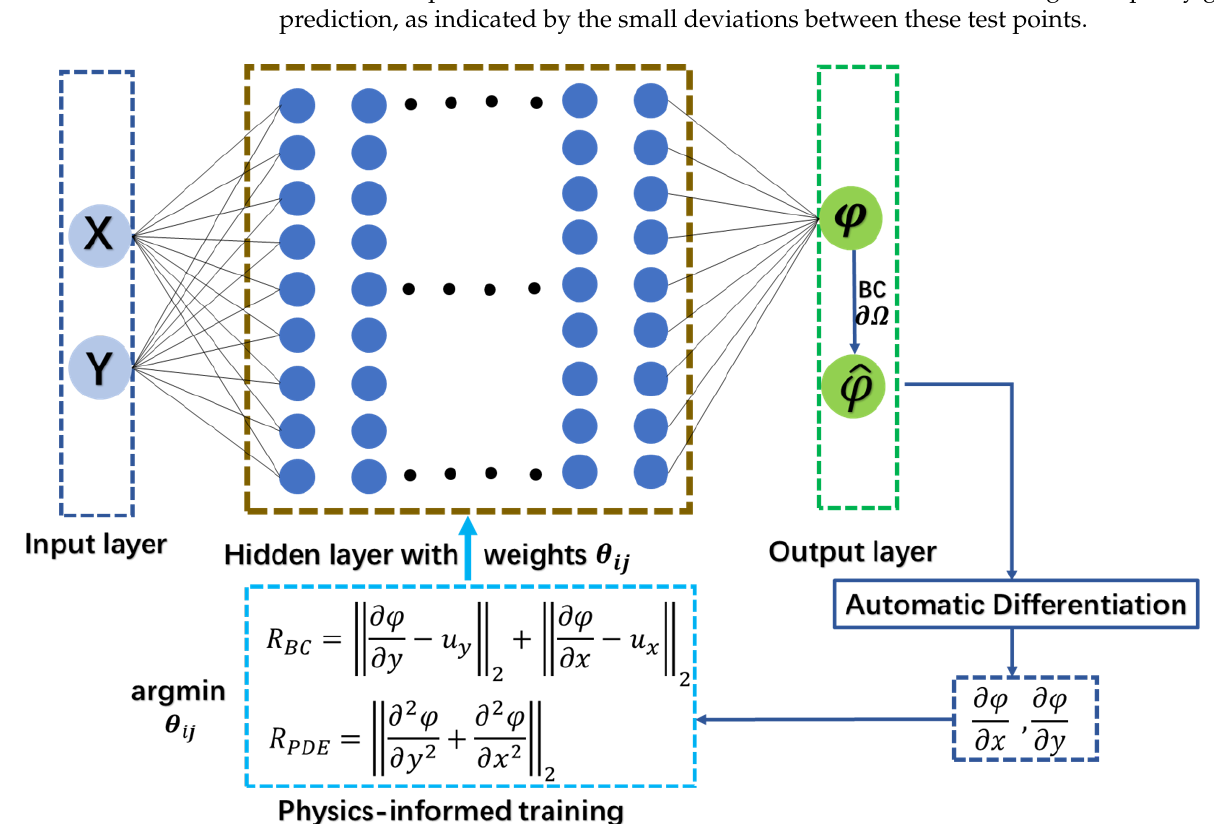
Figure 4. Schematic of constructed physics-based neural network architecture. The input layer has two neurons as placeholders for data coordinate ( x , y ), and the output layer has a single for the predicted velocity potential. N refers to the number of hidden layers, and each hidden layer is composed of N n neurons. Each neuron (blue dot) is connected to the nodes of the previous layer with adjustable weights and bias. BC denotes the boundary conditions specified in Figure 3.